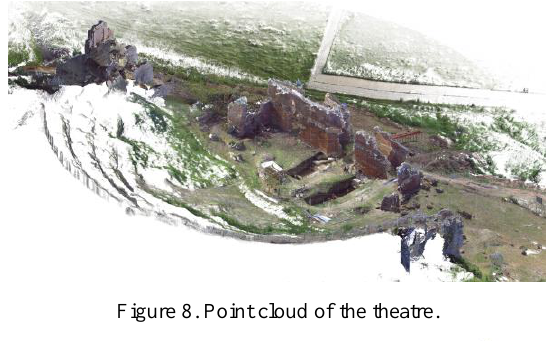
Figure 8. Point cloud of the theatre.